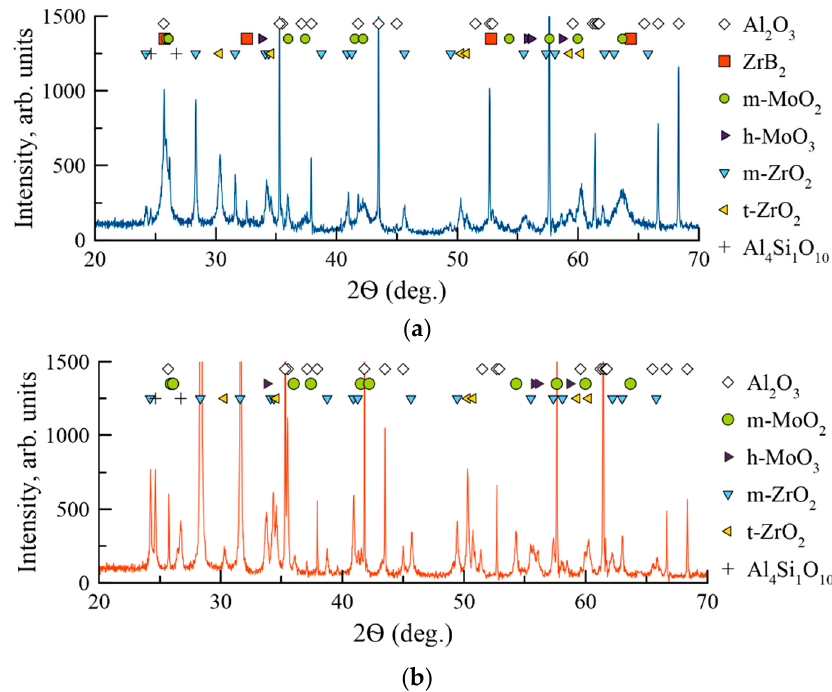
Figure 10. XRD patterns of Coatings 1A ( a ) and 2N ( b ) after annealing in air at 1000 °C.